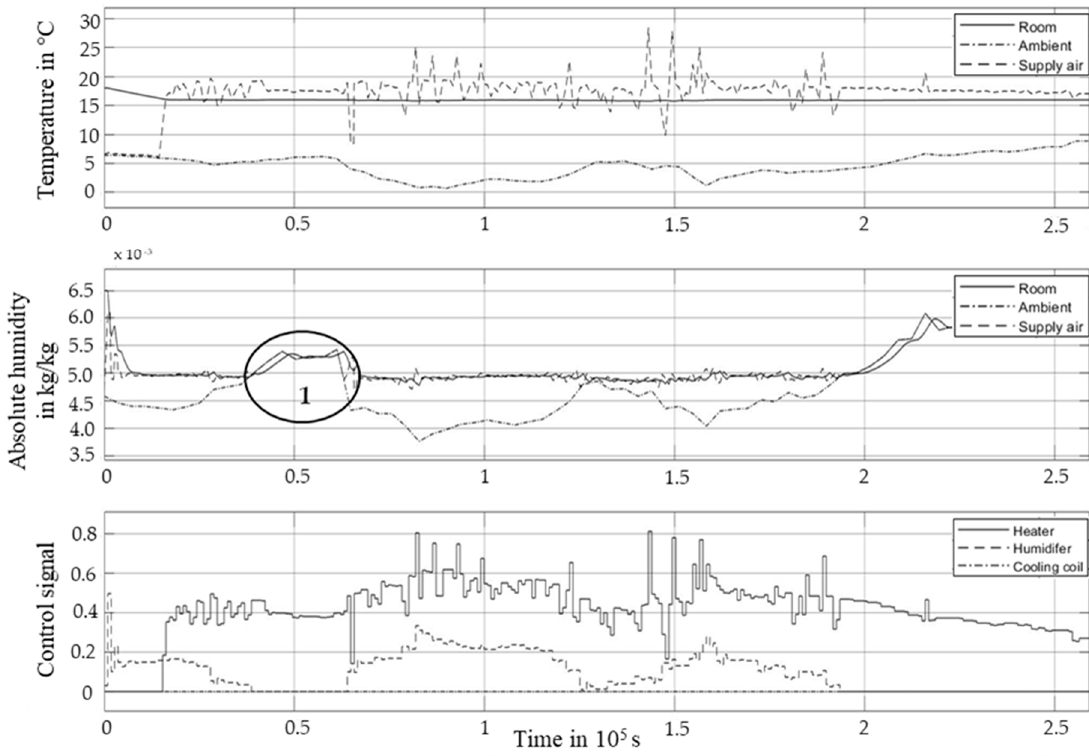
Figure 4. Energy-optimised MMPC over three days in January.